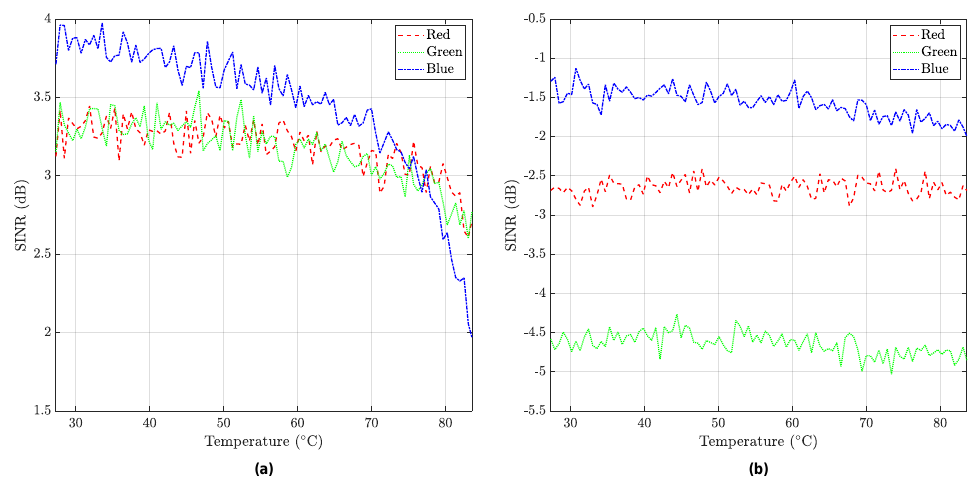
Figure 15. SINR at different temperatures, compensating the channel using the CSI corresponding to 27°C and with a low SNR value (10 dB). ( a ) Sony IMX249 and ( b ) Foveon X3. Dashed line, dotted line, and dash-dot line correspond to red, green, and blue, respectively.